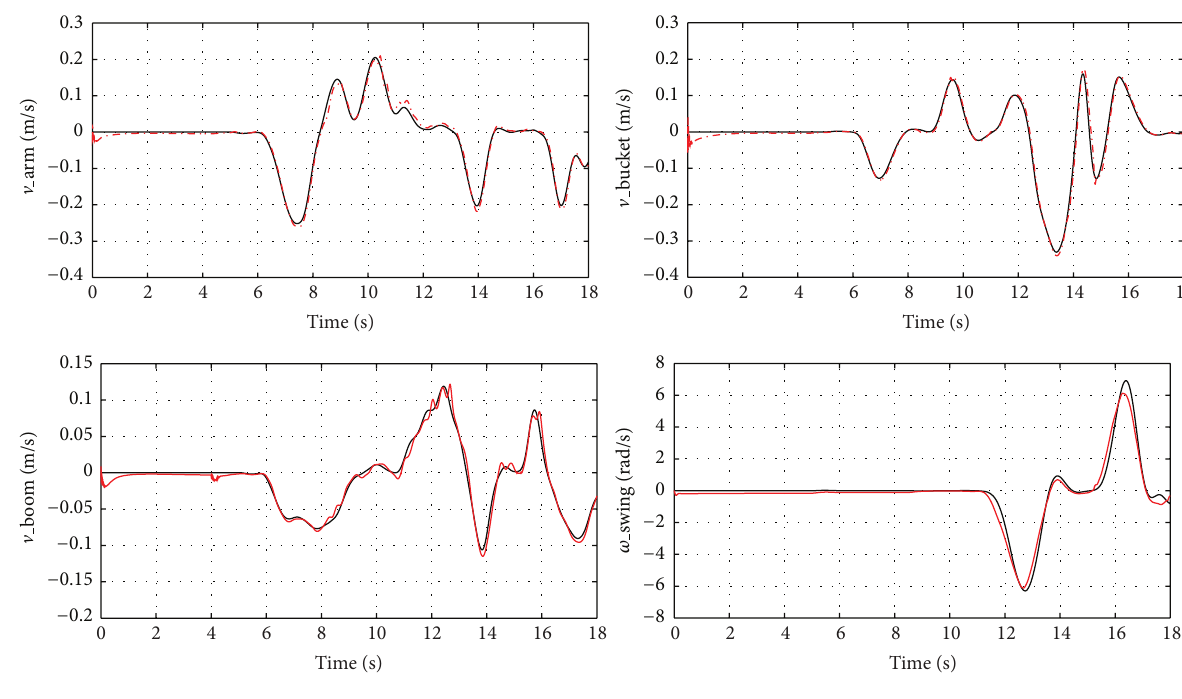
Figure 13: Speed response of each actuator.